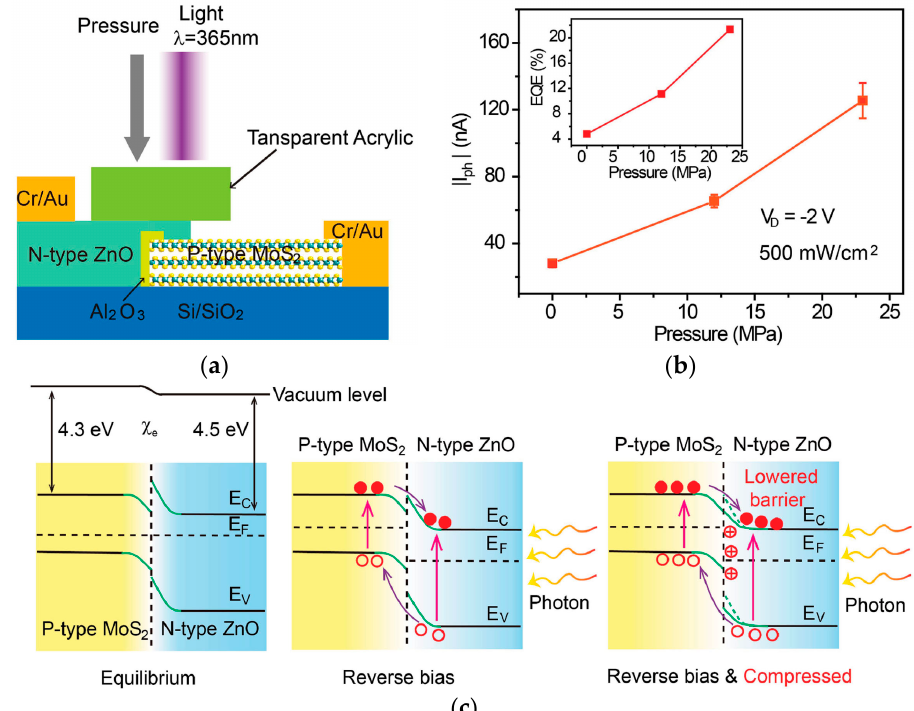
Figure 4. Photoelectric response of a 2D semiconductor/piezoelectric ceramic heterostructure. ( a ) Schematic of experimental set-up for testing the diode; ( b ) Pressure dependence of I ph at a drain bias of –2 V and an incident power density of 500 mW cm − 2 . The inset shows the increased EQE with the increased applied pressure; ( c ) Band diagrams interpreting photogenerated carriers and piezophototronic effect enhanced photocurrents (Fei Xue et al. [55]).